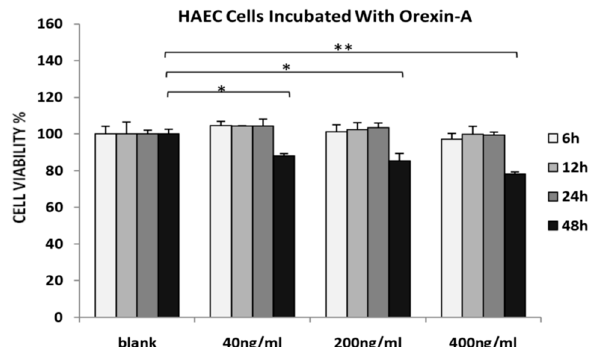
Figure 1. MTS assay. HAECs treated with 40, 200 and 400 ng/mL orexin-A for 6, 12, 24, and 48 h. The graphical data are represented as mean ± SD of at least three independent experiments (* p < 0.05, ** p <